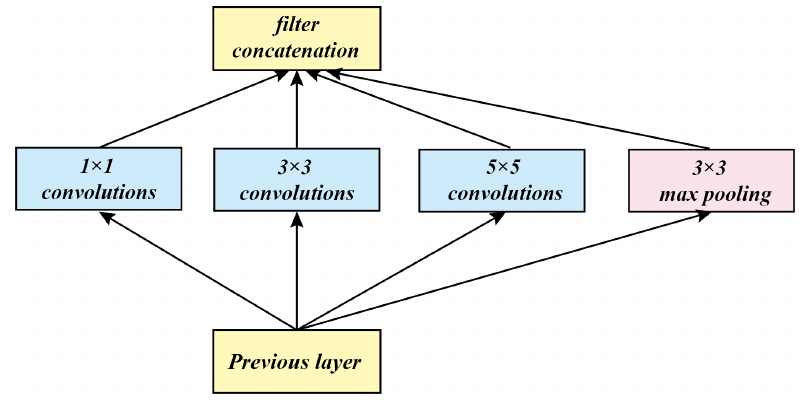
Figure 1. Inception V1